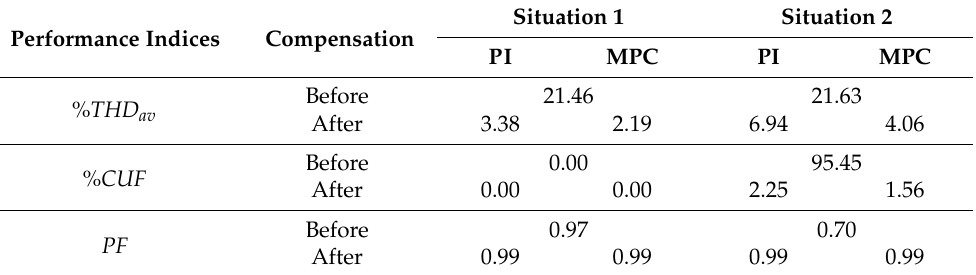
Table 2. The performance indices of the harmonic